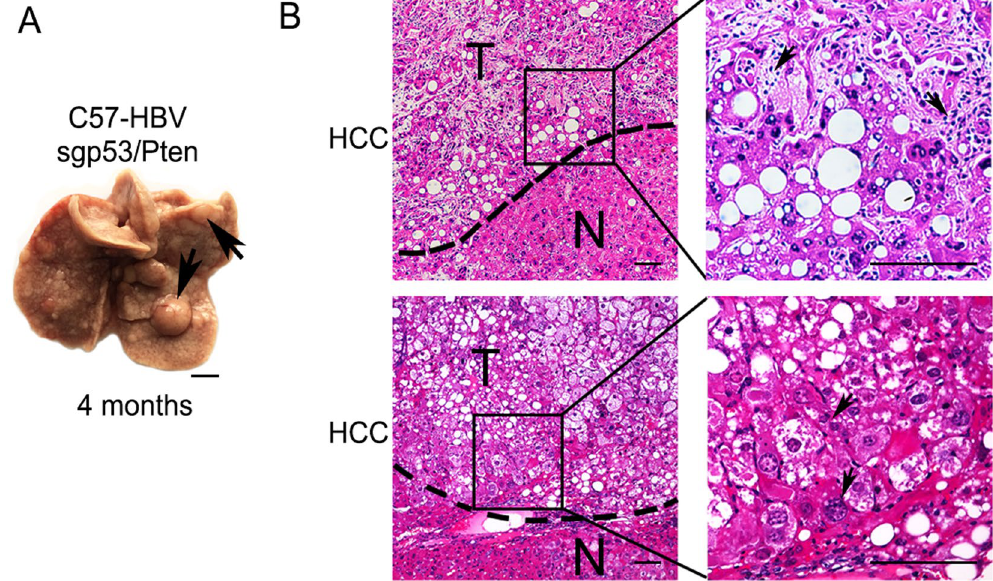
Figure 3. Liver tumors observed in C57-HBV mice with sgp53/Pten dual cassette. ( A ) Macroscopic view of representative liver tumors (arrows) observed in C57-HBV mice 4 months’ post injection. The scale bar is 5 mm. ( B ) H&E-stained section of the tumor (the small one in A) showing the HCC with lipid accumulation and a trabecular-like arrangement that disrupts normal liver architecture. H&E-stained section of the tumor (the big one in A) showing its cytological atypia such as huge nuclei and multinuclear hepatocytes and foamy, reticulated pattern in cytoplasm of HCC. T, tumor; N, non-tumor. The scale bar is 100 μ